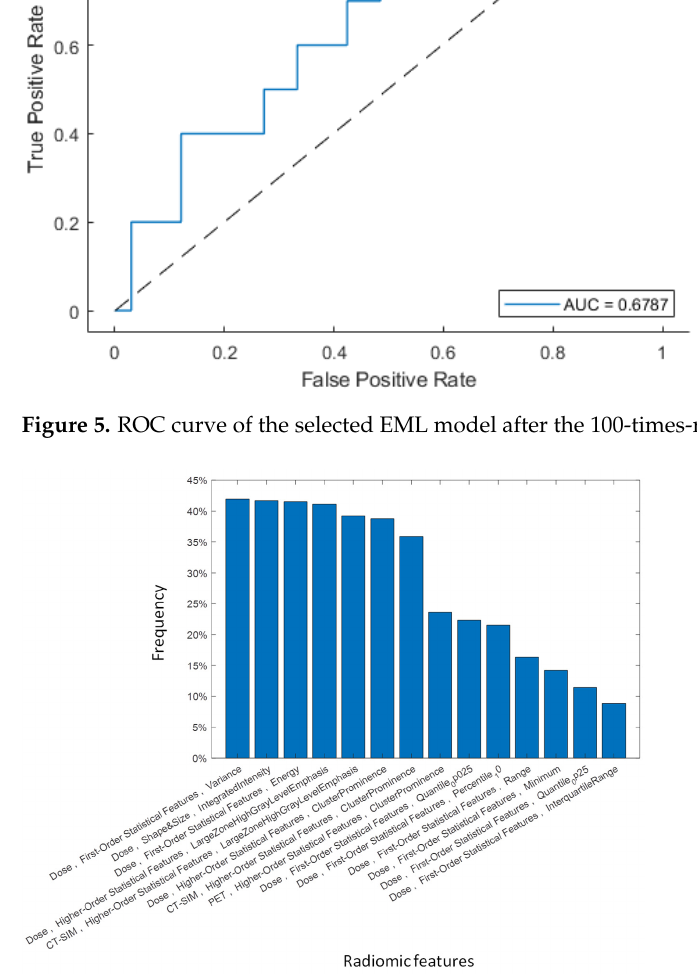
Figure 6. Histogram of the most frequently selected variables in the neighborhood component analysis feature selection during the 100-times-repeated 10-fold CV.